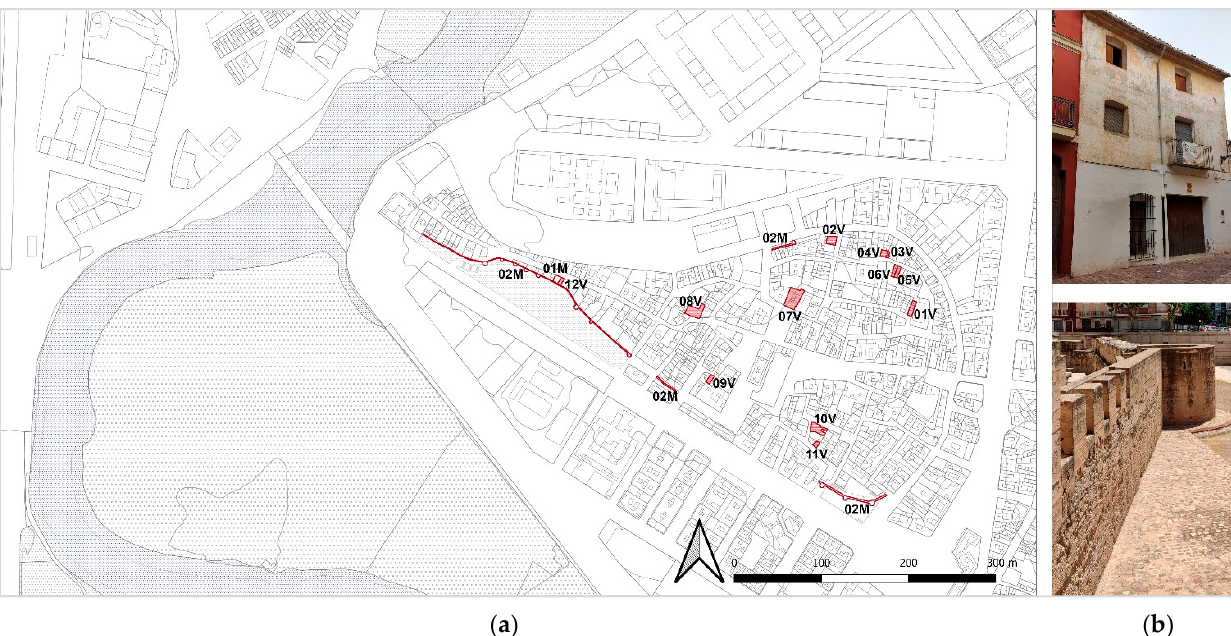
Figure 6. ( a ) Map of the Vila de Alzira. Case study locations. ( b ) Two heritage buildings: 07V (above) and 02M (below).